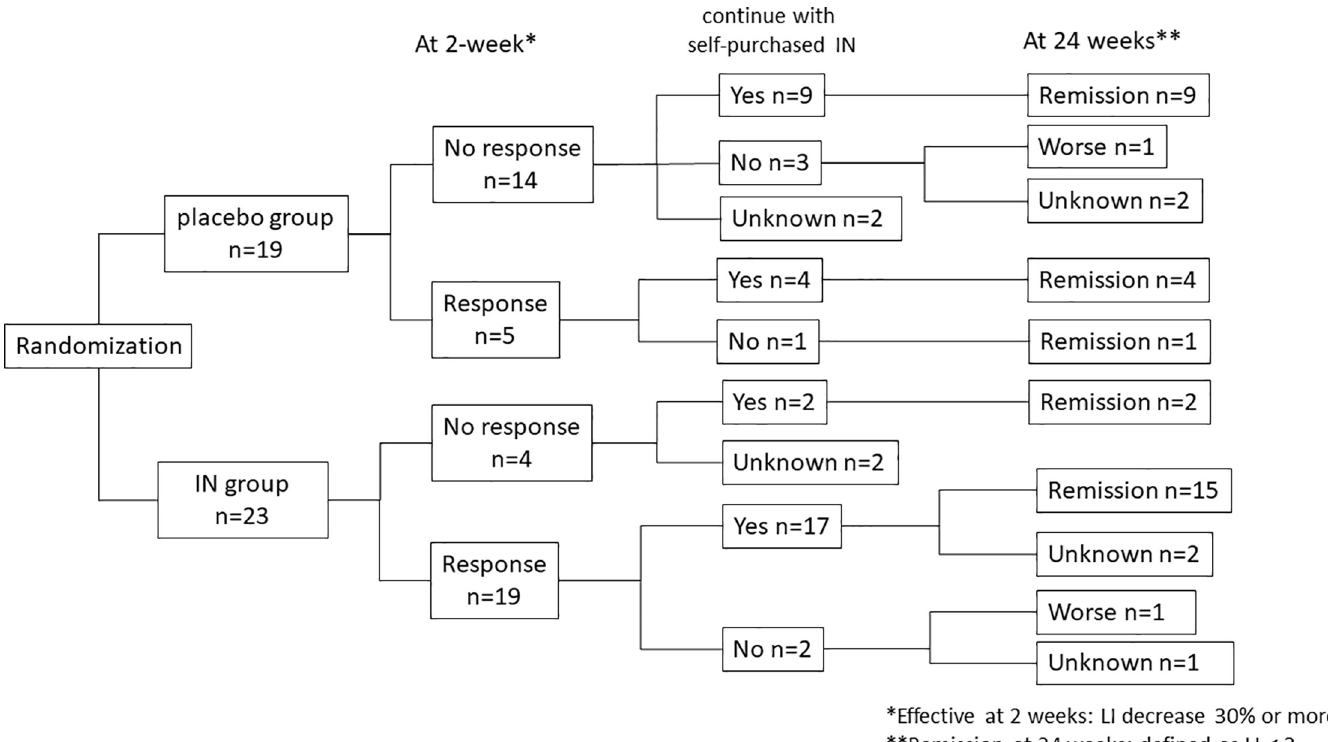
Fig 5. Survey results 24 weeks after the start of the research. IN: indigo naturalis; LI: Lichtiger index.